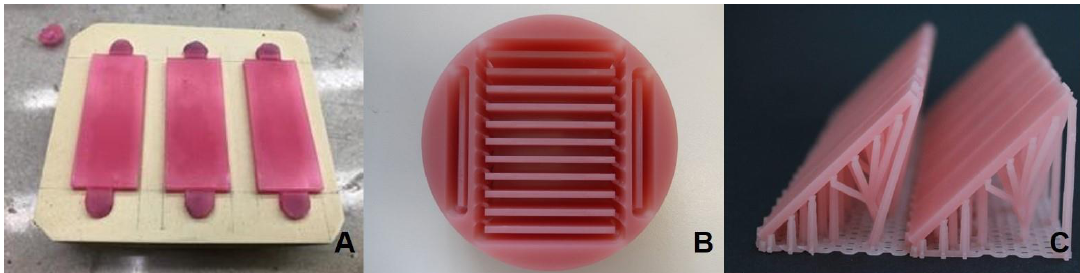
Figure 2. ( A ): Conventional specimens constructed in wax for further casting process. ( B ): Subtractively manufactured specimens in the polymethyl methacrylate (PMMA) block. ( C ): Additively manufactured specimens with the 45º printing orientation.